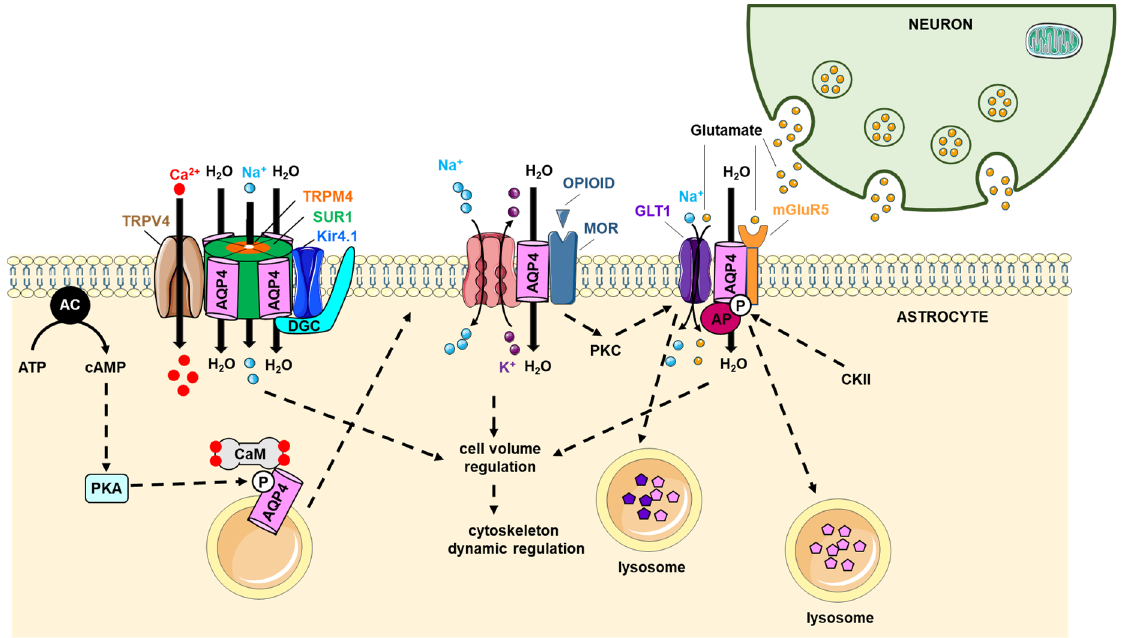
Figure 6. Role of the protein–protein interaction involving AQP4 in astrocytes. The AQP4–TRPV4 interaction plays a role in AQP4 trafficking for calcium entry via TRPV4 binding to CaM. CaM binding, reinforced by AQP4 phosphorylation by PKA, enables AQP4 to move to the plasma membrane. In the plasma membrane, AQP4 also interacts with SUR1, TRPM4, Kir4.1, and DGC. AQP4 also binds to MOR, GLT1, AP, Kir4.1 and Na,K ATPase. CKII can phosphorylate AQP4 to promote its lysosomal targeting and degradation. These protein–protein interactions are likely playing a role in cell volume regulation and cytoskeleton dynamics. AP: clathrin assembly protein complex; CaM: calmodulin; CKII: casein kinase II; DGC: dystrophin-glycoprotein complex; GLT1: glutamate trans- porter 1; Gs: protein Gs; Kir4.1: inwardly rectifying potassium channel Kir4.1; mGluR5: metabo- tropic glutamate receptor 5; MOR: mu opioid receptor; Na,K ATPase: sodium, potassium ATPase pump; PKA: protein kinase A; PKC: protein kinase C; SUR1: Sulfonylurea receptor 1; TM2: trans- membrane domain 2; TRPM4: Transient Receptor Potential Cation Channel Subfamily M Member 4; TRPV4: Transient Receptor Potential Cation Channel Subfamily V Member 4; µAP 2/3: clathrin assembly protein complexes 2 and 3 µ subunit.